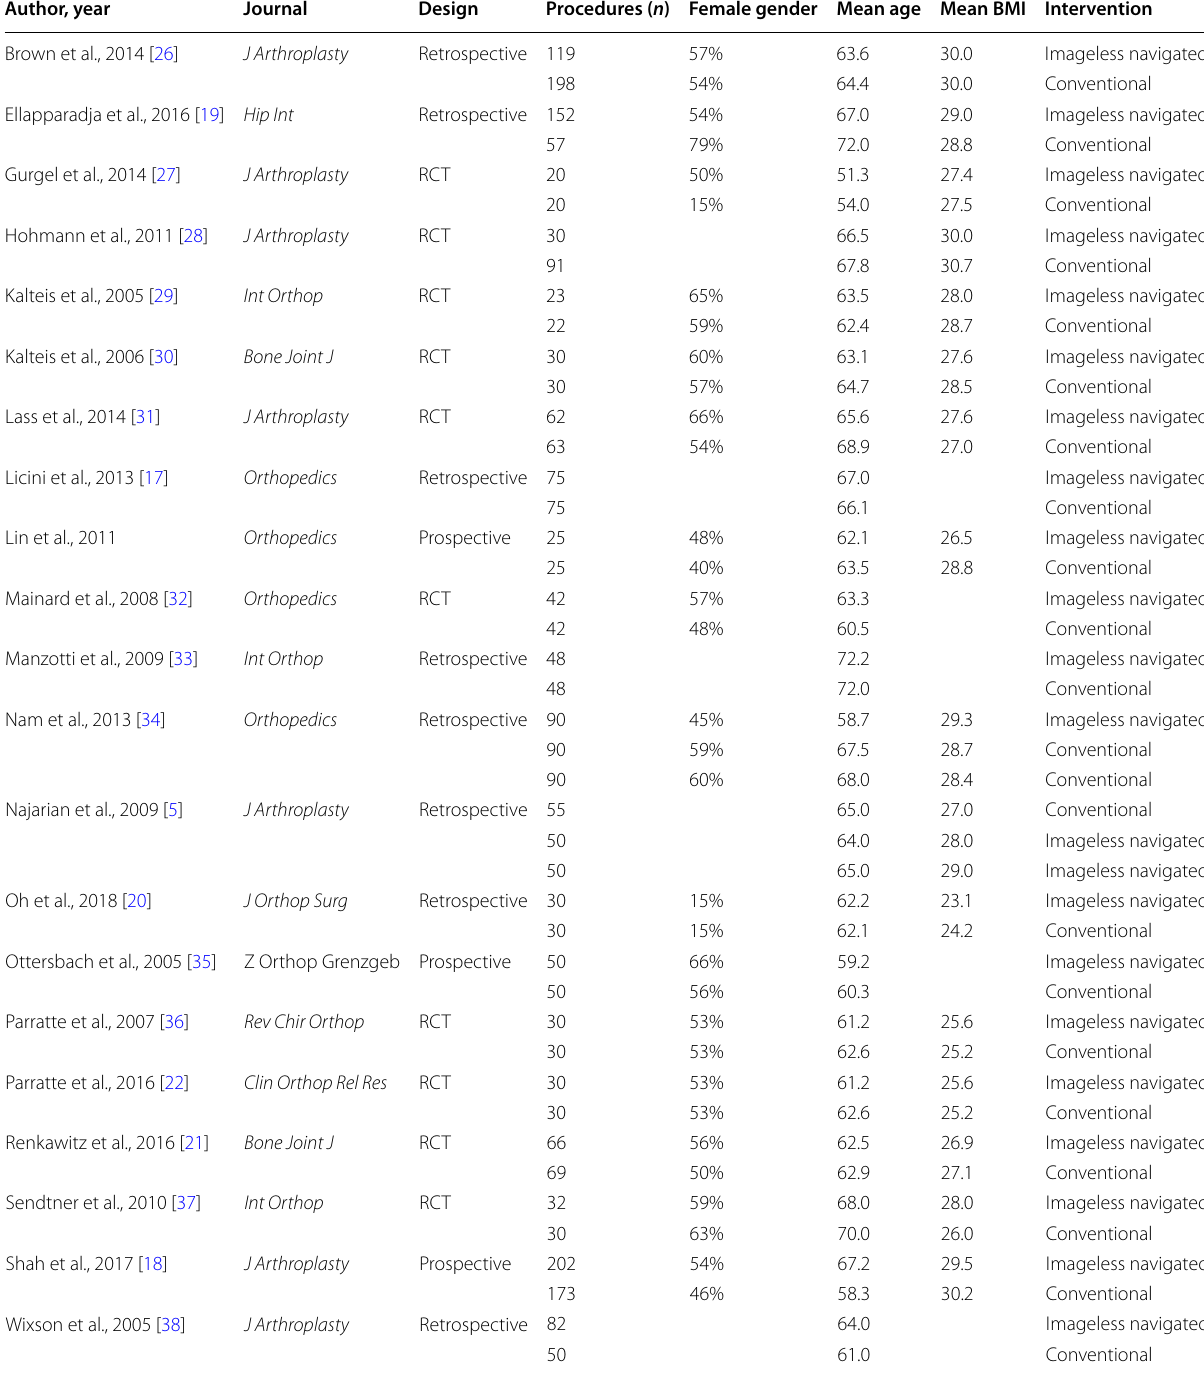
Table 2 Generalities and patient baseline of the included studies; RCT, randomized clinical trial Author,